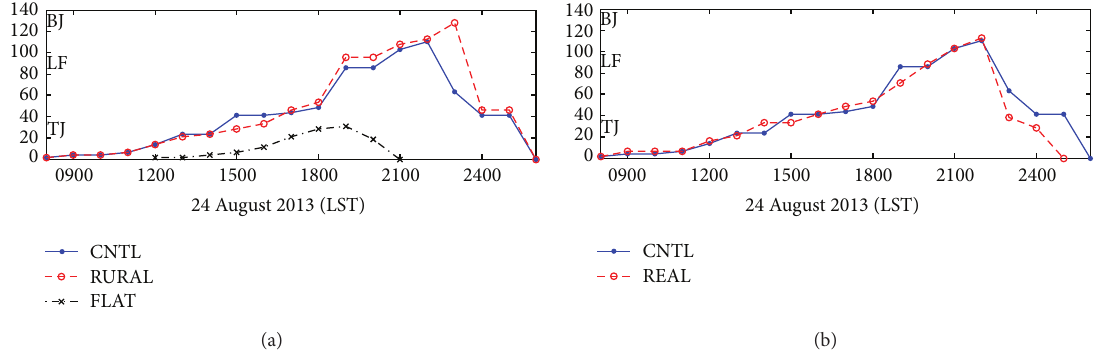
Figure 9: The time series of the maximum inland distance of different numerical experiments within the vertical cross section from A to B in Figure